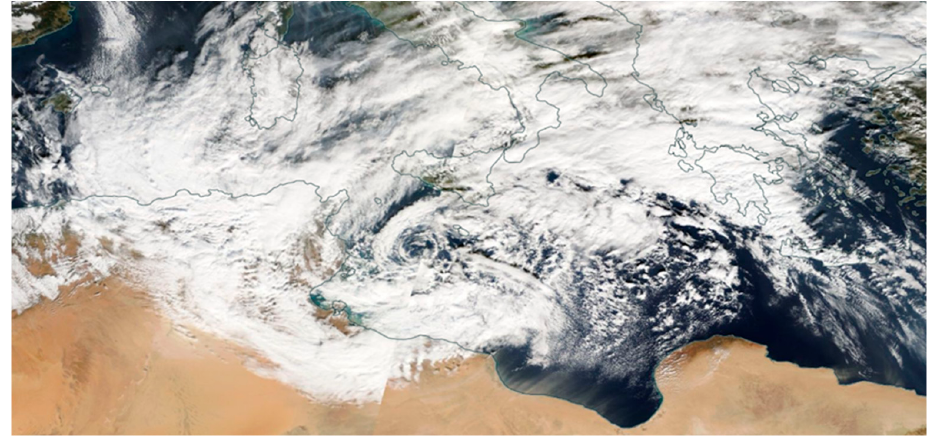
Figure 1. Satellite image of the medicane, on 14 December 2005. Terra/Modis imagery, taken from: https://worldview.earthdata.nasa.gov, (accessed on 27 April 2021) (NASA Worldview, EOSDIS).